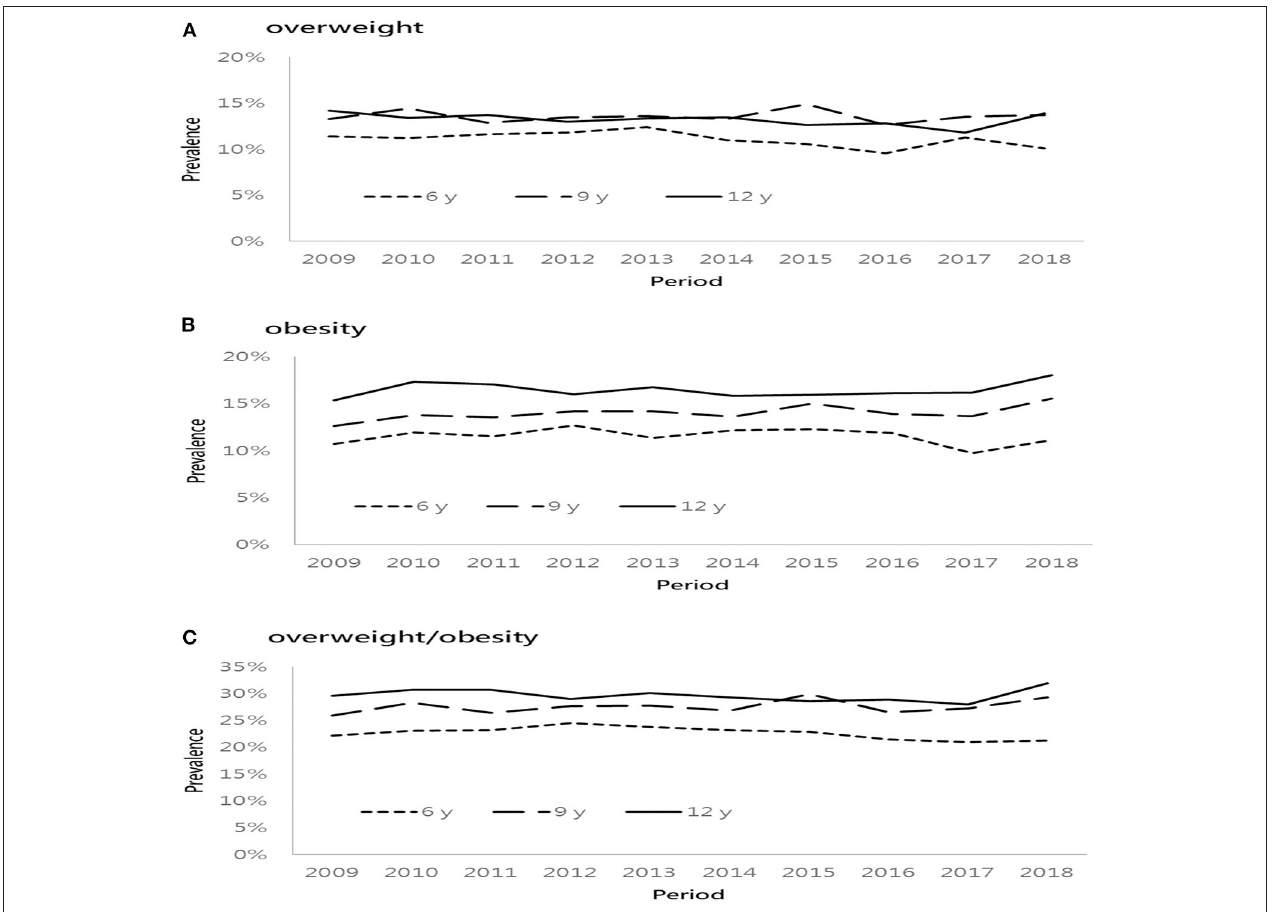
FIGURE 1 | Age-specific prevalence of overweight and obese from 2009 to 2018. (A) overweight, (B) obesity, and (C)